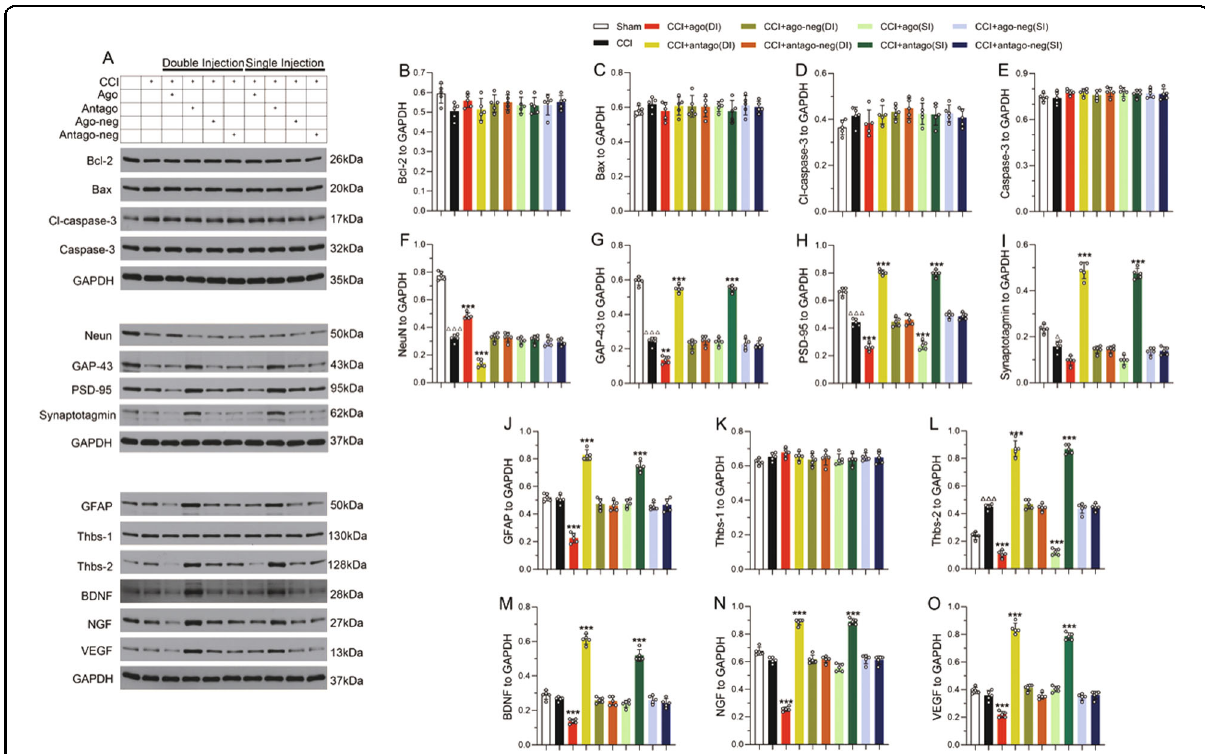
Fig. 2 Downregulation of miRNA-9-5p promoted the proliferation of astrocytes and the expression of astrocyte-derived neurotrophic factors in the chronic phase after TBI. A The immunoblotting and quantitative data of B Bcl-2, C Bax, D cleaved caspase-3, E caspase-3, F NeuN, G GAP-43, H PSD-95, I synaptotagmin, J GFAP, K Thbs-1, L Thbs-2, M BDNF, N NGF, and O VEGF were detected at 35 days after CCI ( n = 5/group). ( △ P < 0.05, △△△ P < 0.001 versus the sham group; ** P < 0.01, *** P < 0.001 versus the CCI group) (CCI: control cortex impact, DI: double injection, SI: single injection). Error bars indicate mean ±